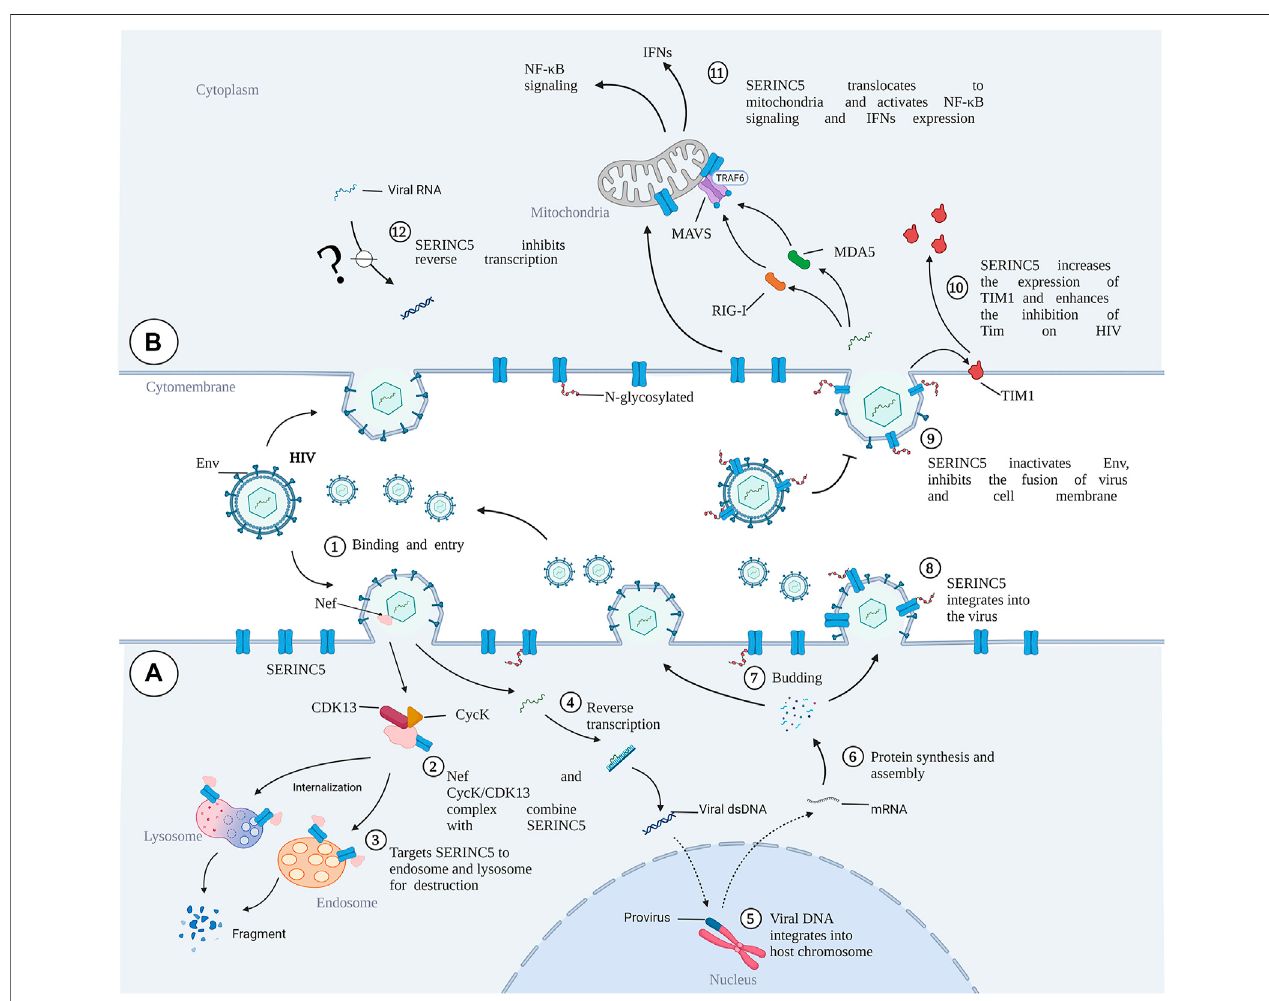
FIGURE 3 | The role of SERINC5 in HIV infection. (A) HIV infects cells and antagonizes SERINC5. (B) SERINC5 inhibits viral infection. SERINC5 proteins are normallylocalized intheplasmamembrane ofthecell.Upon viralinfection, Nefforms complexeswithCycK andCDK13, combining withSERINC5 totargetSERINC5 to endosomes and lysosomes for destruction. During HIV budding, an N-glycosylated and high-molecular-weight form of SERINC5 preferentially integrates into virions. If viruses carrying SERINC5 infect other cells, the packaged SERINC5 will exert several antiviral activities. SERINC5 can interfere with Env activity and prevent Env folding, reducing the fusion between cells. SERINC5 increases the expression of TIM1 and enhances the inhibition of Tim on HIV. SERINC5 becomes internalized and translocates to the mitochondrial membrane, where it is associated with MAVS and TRAF6, resulting in MAVS aggregation and polyubiquitylation of TRAF6. MVAS recognizes viral MDA5 and RIG-I, enhancing the expression of genes encoding type I interferons (IFNs) and nuclear factor κ B (NF- κ B) signaling. MDA5, melanoma differentiation gene 5; RIG-I, retinoic acid-inducible gene I; Cyck, cyclin K; CDK13, cyclin-dependent kinase 13. (Created by Biorender.com).